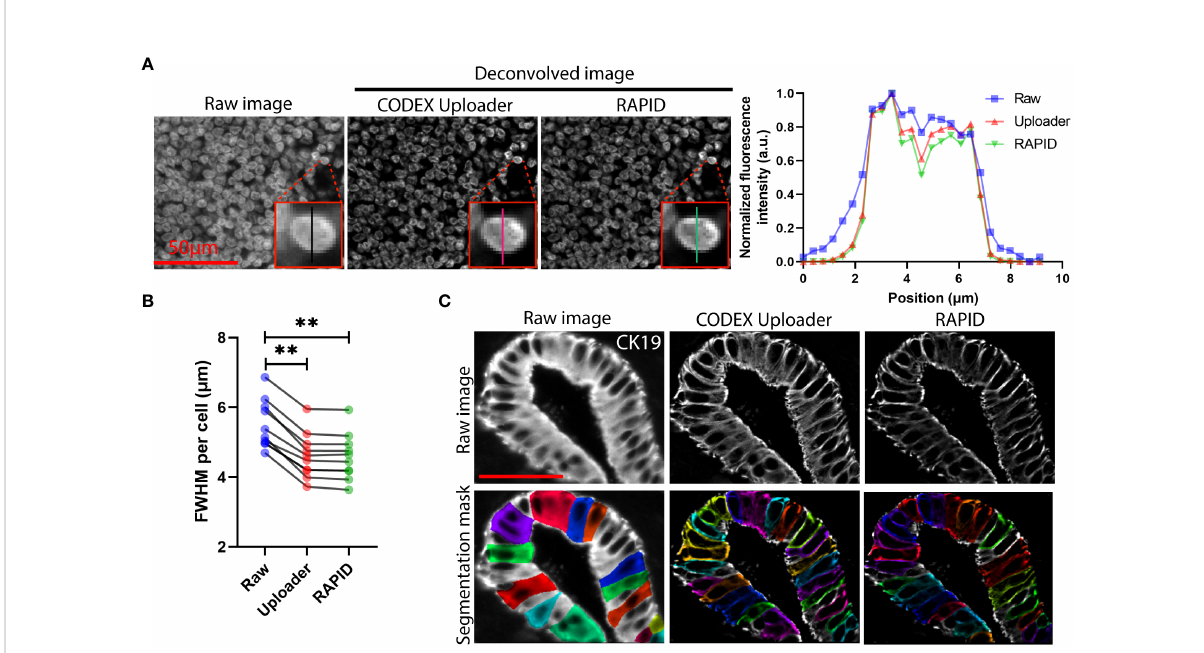
FIGURE 2 3D image deconvolution improves image contrast in CODEX data. (A) Representative raw and deconvolved images of a cervical lymph node, and plot of normalized fl uorescence intensity versus lateral position of a selected cell corresponding to the raw and deconvolved images. (B) Quanti fi cation of the FWHM for signals cross ten randomly selected cells. (C) Representative raw and deconvolved images of cytokeratin 19-stained pancreatic ducts and corresponding predicted whole-cell segmentation mask. Wilcoxon matched-pairs signed rank test was used in ( B ). **P <